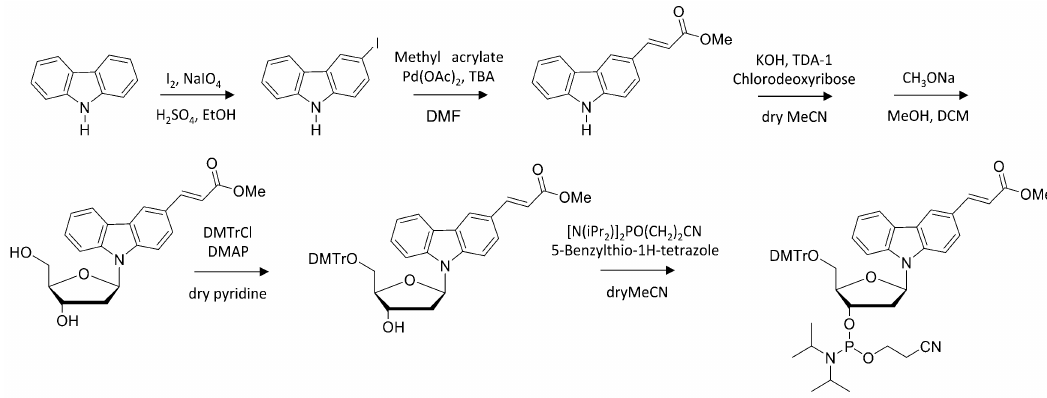
Scheme 1. Synthetic scheme for preparation of photo-responsive nucleotide.